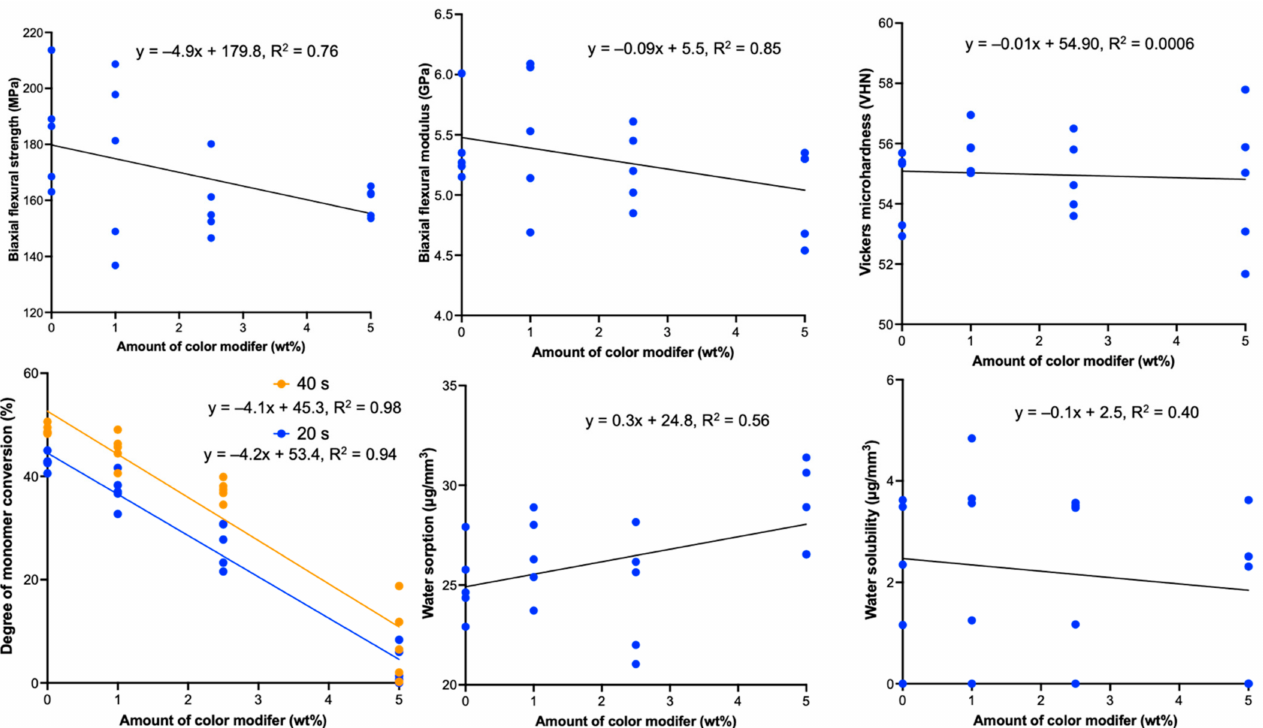
Figure 5. The linear regression of each property versus the amount of the color